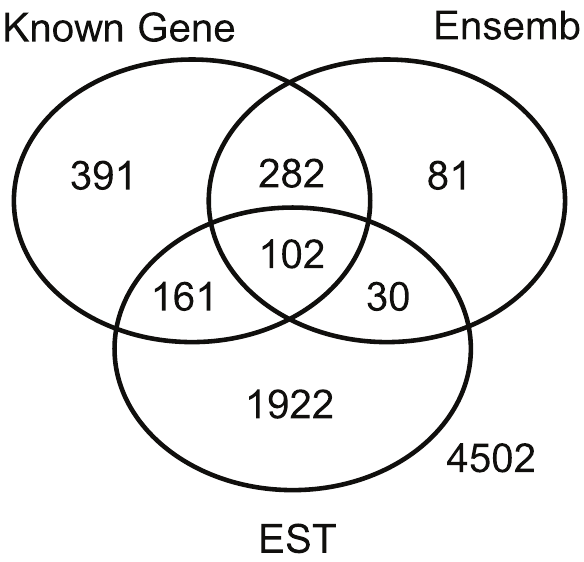
Figure 1. Coverage of the 7,471 new exons identified from RNA-Seq data in other databases. ExonMap was applied to the RNA-Seq data using RefSeq as a reference. 7,471 new exons were identified which were not annotated in RefSeq, among which 4,502 were not annotated in UCSC Known Genes, Ensembl, and EST databases.